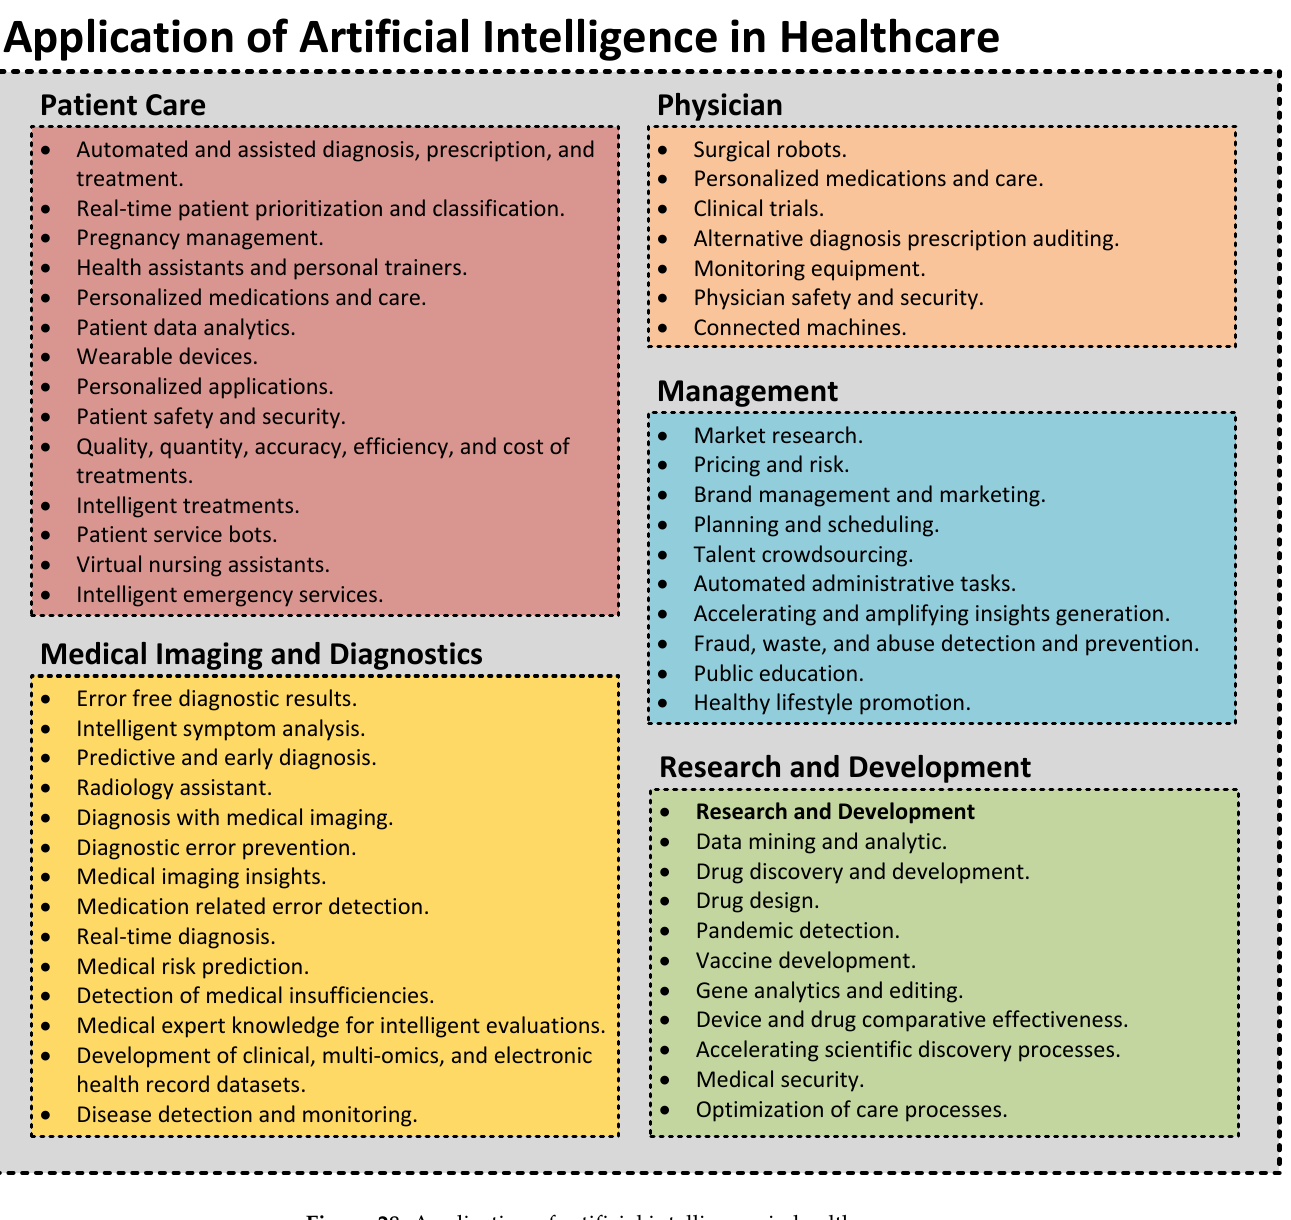
Figure 28. Application of artificial intelligence in healthcare.